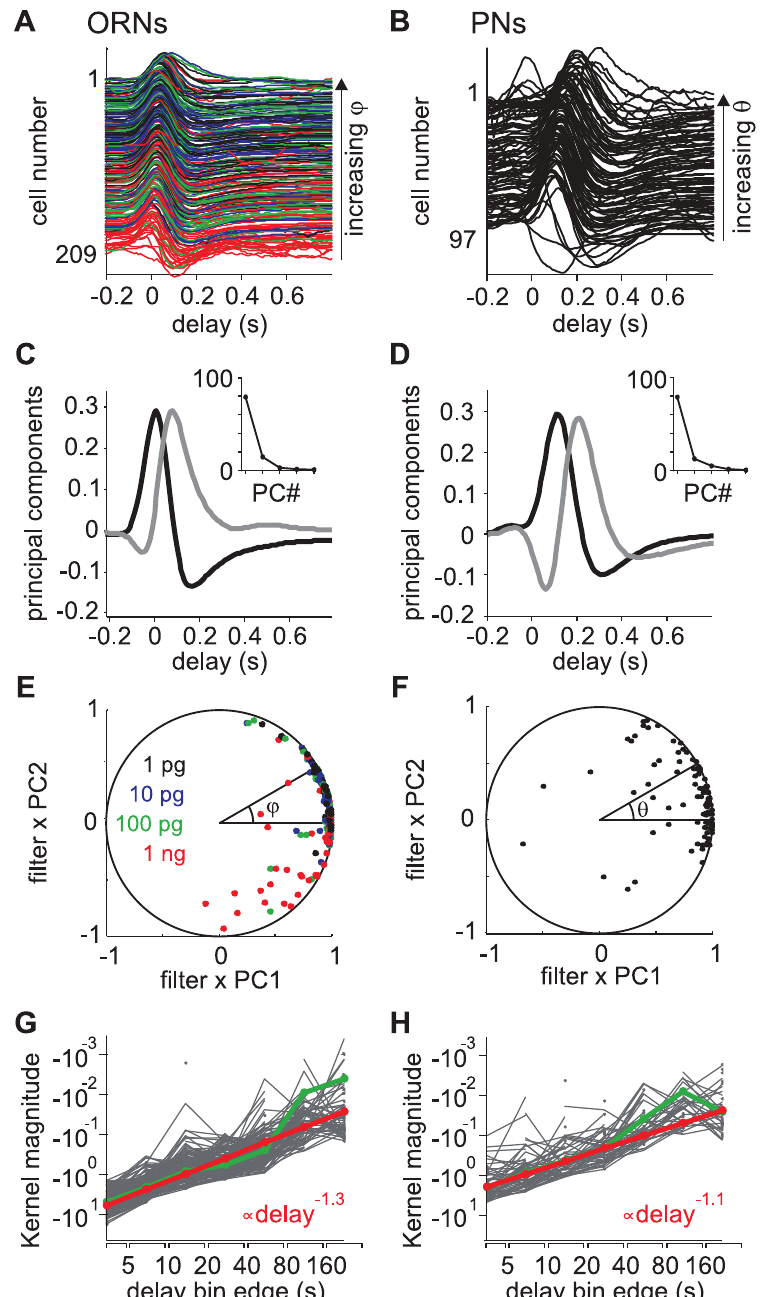
Fig 4. Parametrization of the shapesof linear filter sets. The diversityof short-term filters is analyzedas in [53].Analysis of the diversityof long-termfilters is adapted from [54].(A) Individualshort-term linearfilters for 209 ORNs sorted by decreasing parameter φ (see (E)). Same color code for the different pheromoneloads in the stimulationpipetteas in (E). (B) Individualshort term linearfilters for 97 PNs, sorted by decreasing θ (see (F)). (C) First (black)and second(grey) principalcomponents of the ORN short-termfilter set. Inset: percentage of variance explainedby the first 5 components. (D) First two principalcomponents for the PN short-term filter set. Same conventions as in (C). The time shift of principal components for PNs when comparedto ORNs reflects the difference of delay for the pheromoneto reach the antennaewith the odor deliverydevicesusedfor ORN and PN recordings.(E) Projectionof normalizedORN short-term filters on the subspacespannedby the first two components. If a filter is solelydescribedby the two components, then the correspondingdot lies on the unit circle. Each short term filter can be parametrized by its angle φ . (F) Projectionof normalized PN